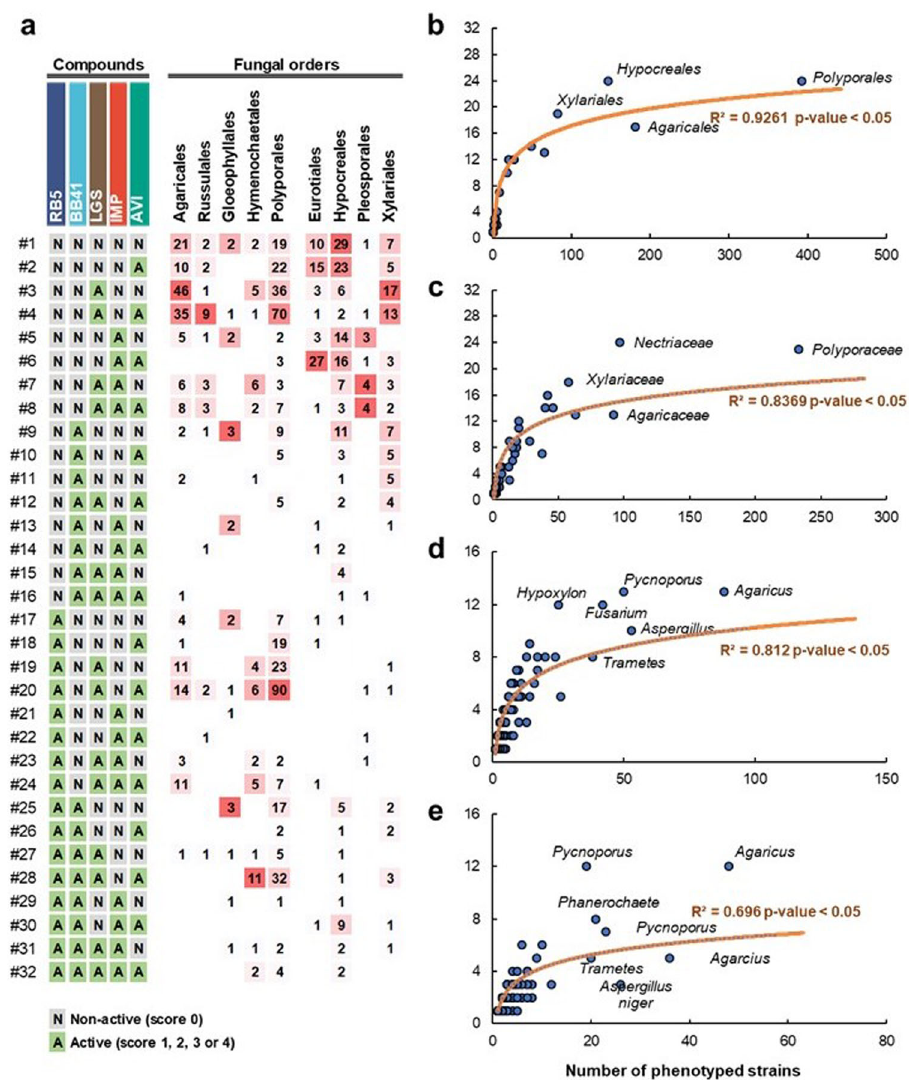
Fig. 5 Overview of the functional diversity at different taxonomic levels. a Distribution of functional pro fi les at the order level. The two-level categorization of non-active (N) and active (A) substrate – strain couples evaluated on 5 different substrates yields a theoretical maximum of 32 pro fi les. For each fungal order, the numbers provided in the matrix represent the number of strains with a given pro fi le (for each fungal order, a color gradient from white (only one strain) to red (maximum number of strains) has been applied to show the distribution of functional pro fi les in the order). As an example, 46 strains from the Agaricales order displayed the pro fi le #3 (LGS oxidation only). b – e Logarithmic regression between the number of functional pro fi les observed ( x axis) within a taxonomic rank (indicated in the fi gure) and the number of analyzed strains ( y axis) in this rank, at the order ( b ), family ( c ), genus ( d ), and species ( e )